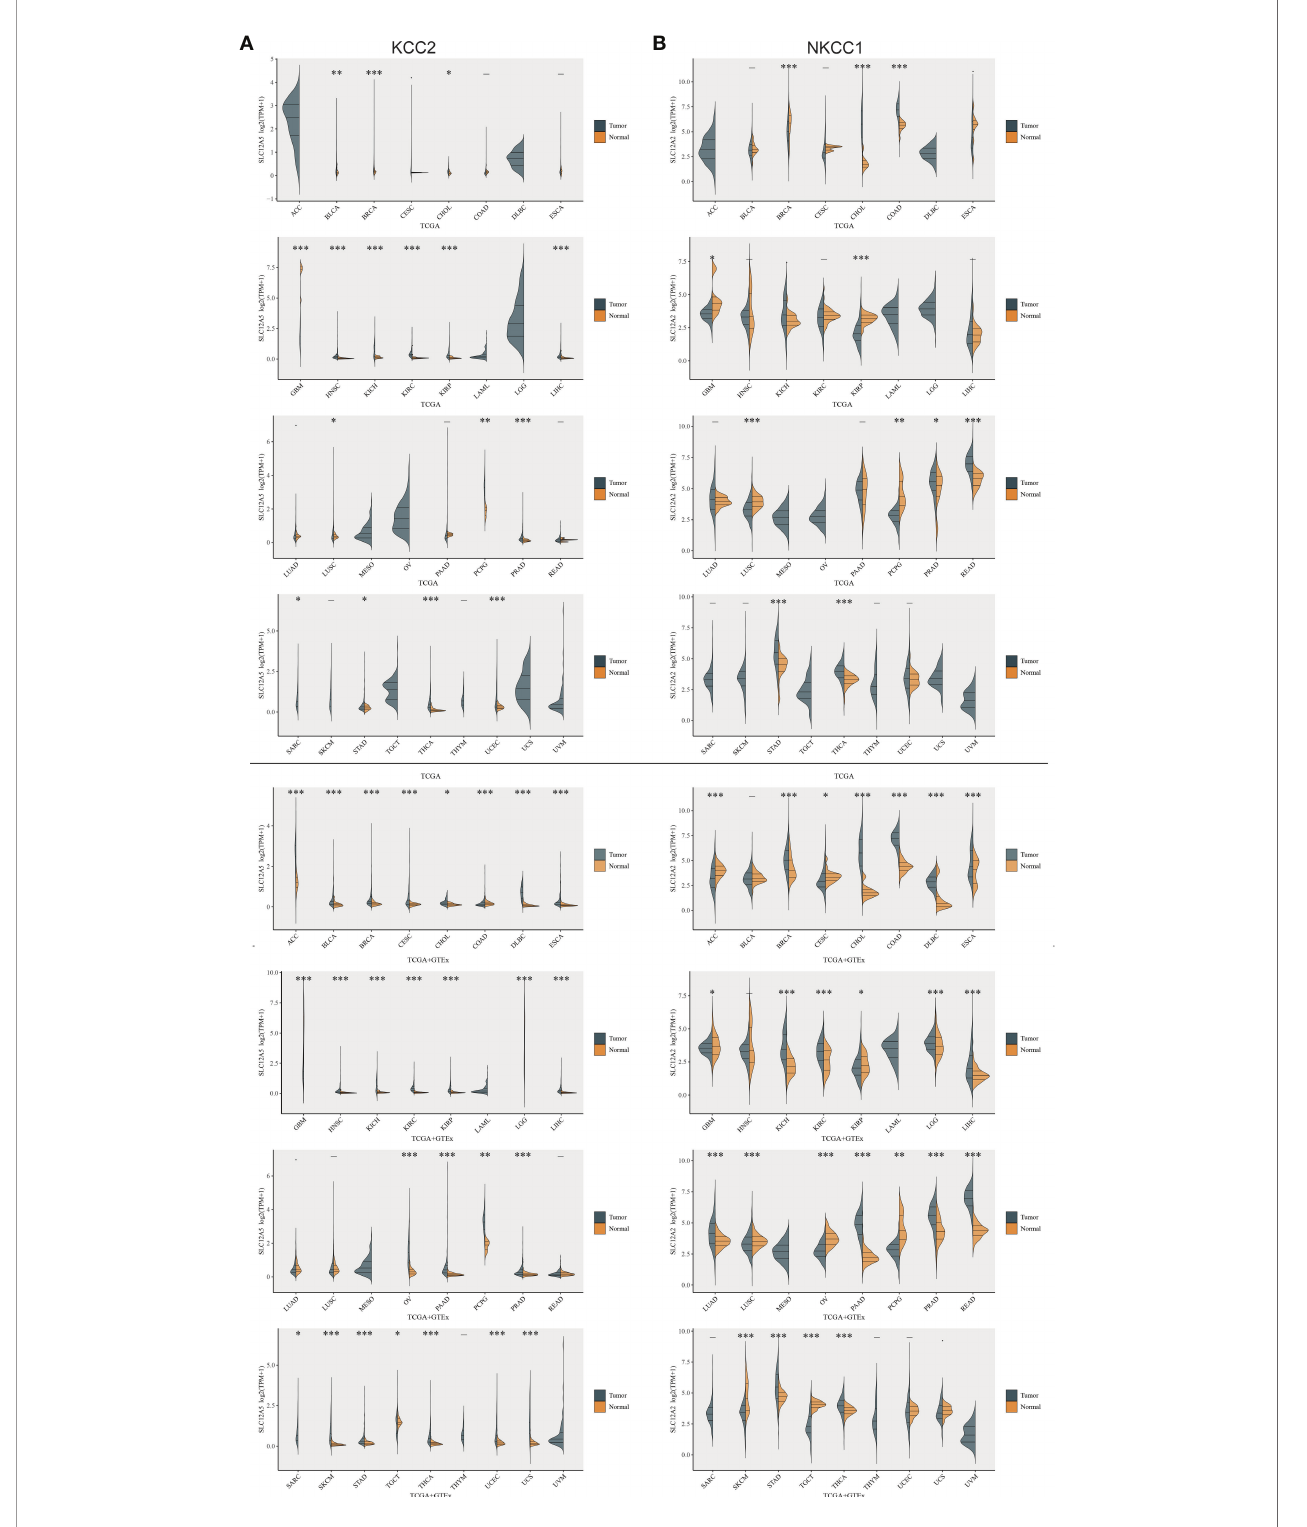
FIGURE 1 | Differential expression of KCC2 and NKCC1 in pan-cancer based on a large-sample database. (A) The differential expression of KCC2 in pan-cancer tissues from TCGA database and normal samples from TCGA and GTEx Portal databases. (B) The differential expression of NKCC1in pan-cancer tissues from TCGA database and normal samples from TCGA and GTEx Portal databases. *p < 0.05, **p < 0.01, ***p <